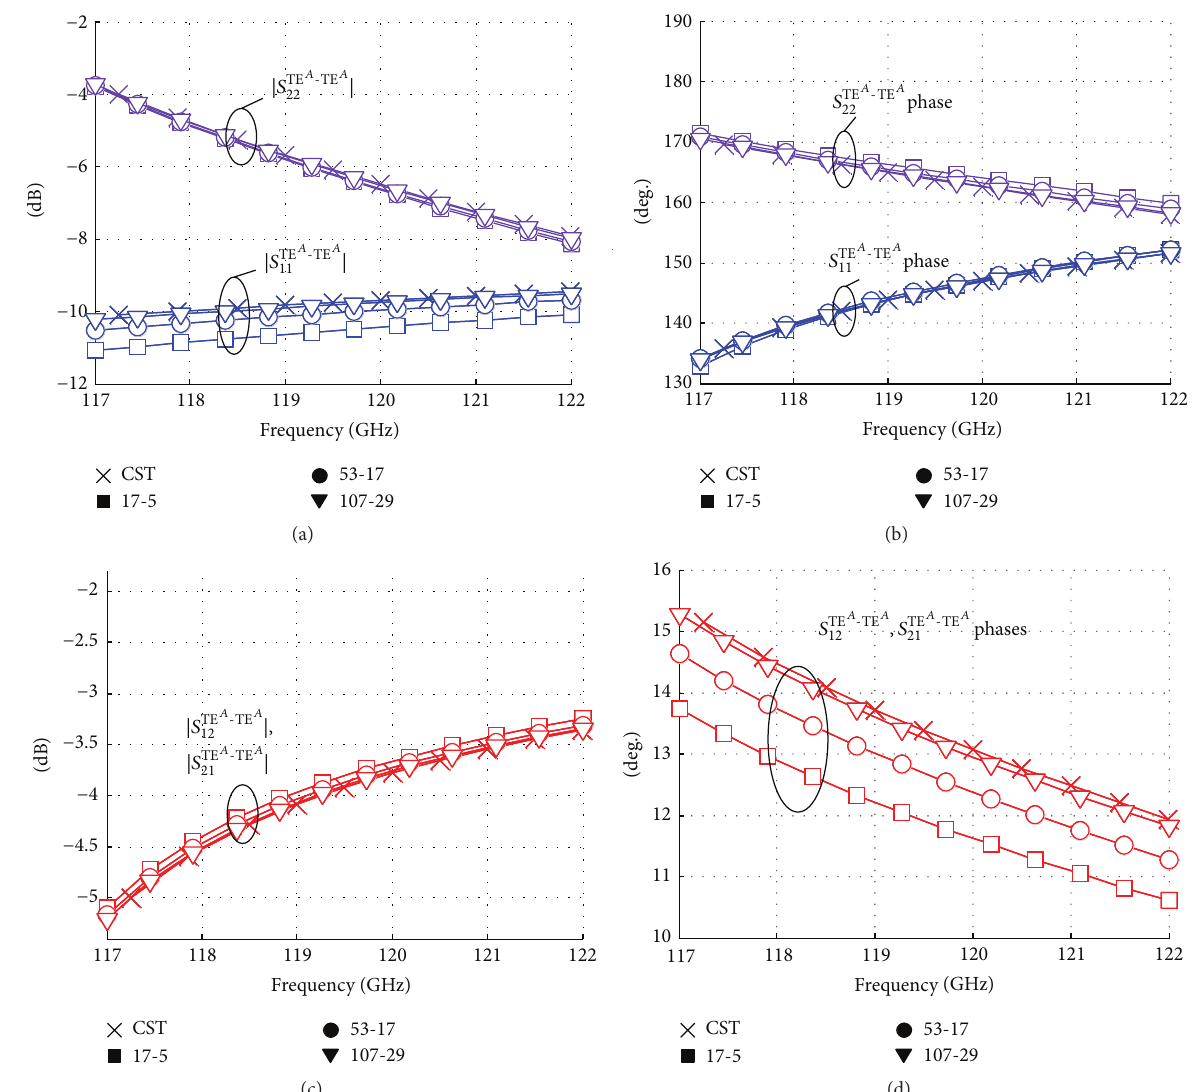
Figure7:Casestudya:modeTE 𝐴 10 inwaveguide 1 tomodeTE 𝐴 10 inwaveguide 2 :(a)reflectionmagnitude,(b)reflectionphase,(c)transmission magnitude, and (d) transmission